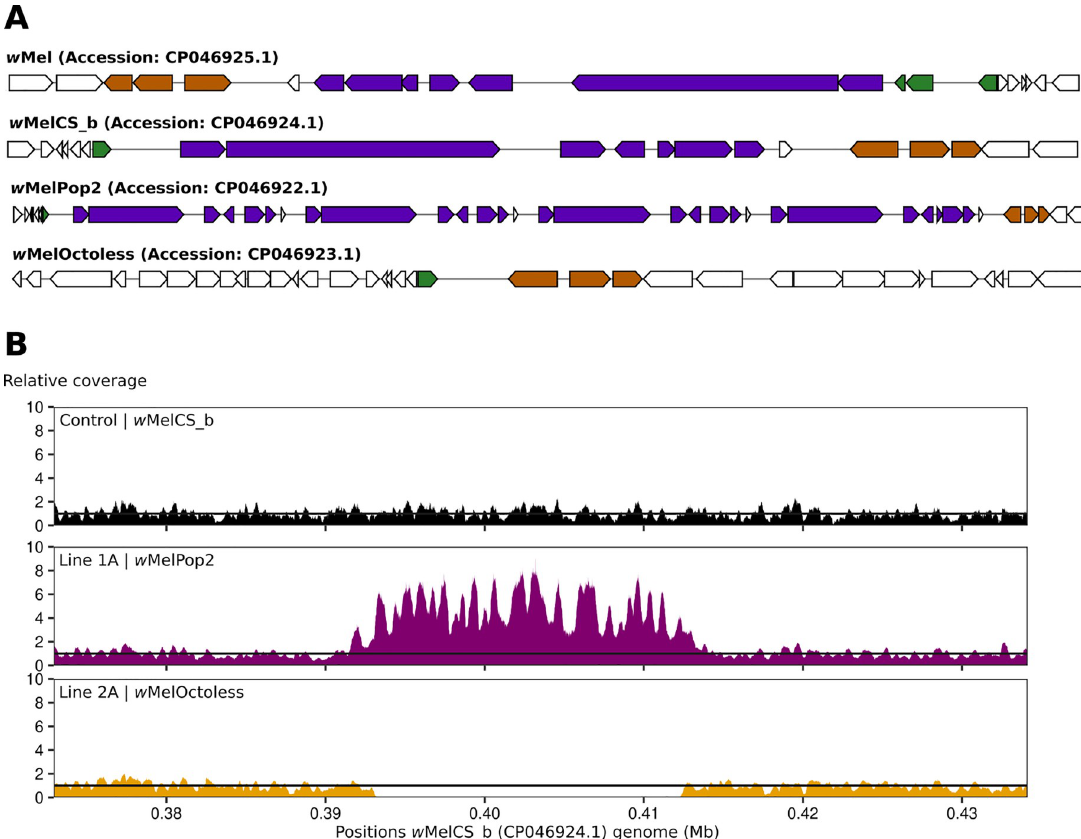
Fig 2. Both amplification and deletion of Octomom lead to Wolbachia over-proliferation. (A) Representation of Octomom region and its flanking region in over-proliferative Wolbachia . De novo assembled genomes of w Mel, w MelCS_b, Line1A ( w MelPop2) and Line 2A ( w MelOctoless) were annotated using the NCBI Prokaryotic Genome Annotation Pipeline v4.10. These representations were generated using MultiGeneBlast v1.1.13 (http://multigeneblast.sourceforge.net/) and identify the homologous genes immediately upstream of Octomom (orange), in the Octomom region (purple), and immediately downstream of Octomom (green), in the w Mel reference genome (GenBank: AE017196.1). Regions are not to scale. Note that the genome annotation differs between this new w Mel genome assembly and the reference genome, although there is no difference between the sequences in this region. (B) Relative coverage in the genomic region containing the Octomom region. Illumina paired-end reads of the different Wolbachia variants were mapped to w MelCS_b genome (GenBank: